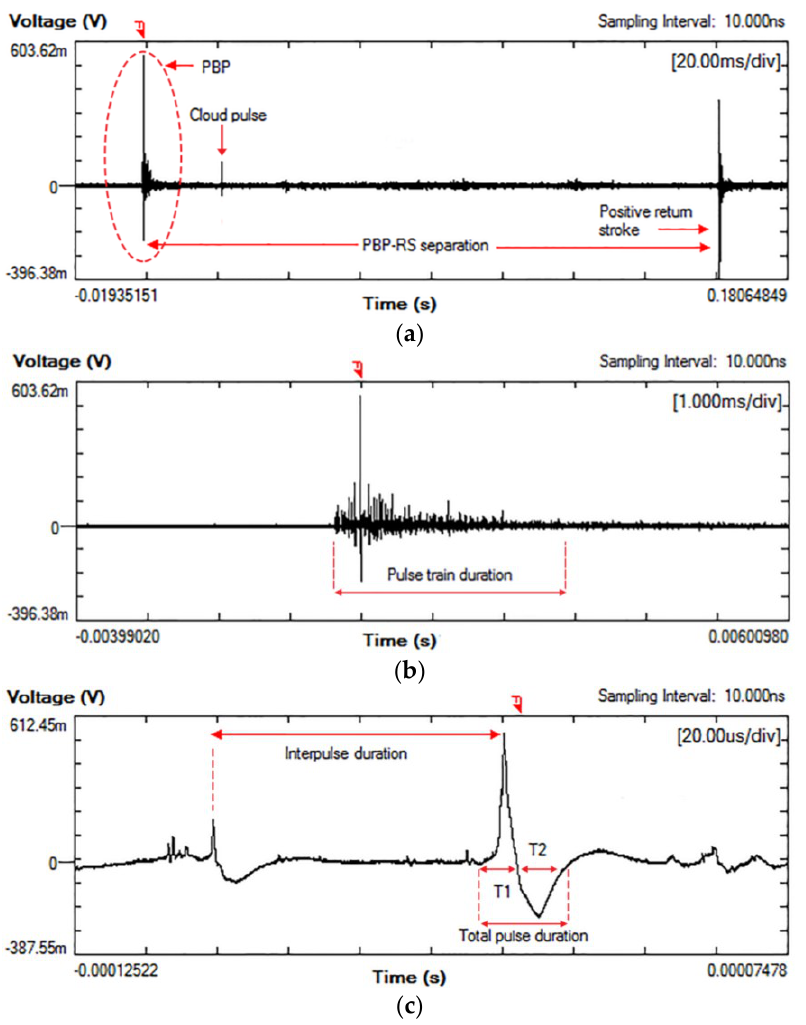
Figure 6. Temporal characteristics of the PBP ( a ) Sample waveform showing PBP-RS separation; ( b ) Zoom in of the waveform showing the pulse train duration; ( c ) Zoom in of the waveform showing the interpulse duration, pulse duration for the first half cycle (T 1 ) and the second half cycle (T 2 ) of an individual bipolar pulse, and total pulse duration (T 1 + T 2 ).